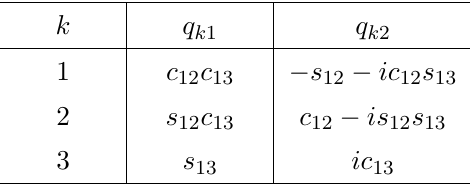
Table 7 . Invariant combinations of the neutral Higgs boson mixing angles (cid:18) 12 and (cid:18) 13 , where c ij (cid:17) cos (cid:18) ij and s ij (cid:17) sin (cid:18) ij . The physical neutral Higgs bosons are linear combinations of